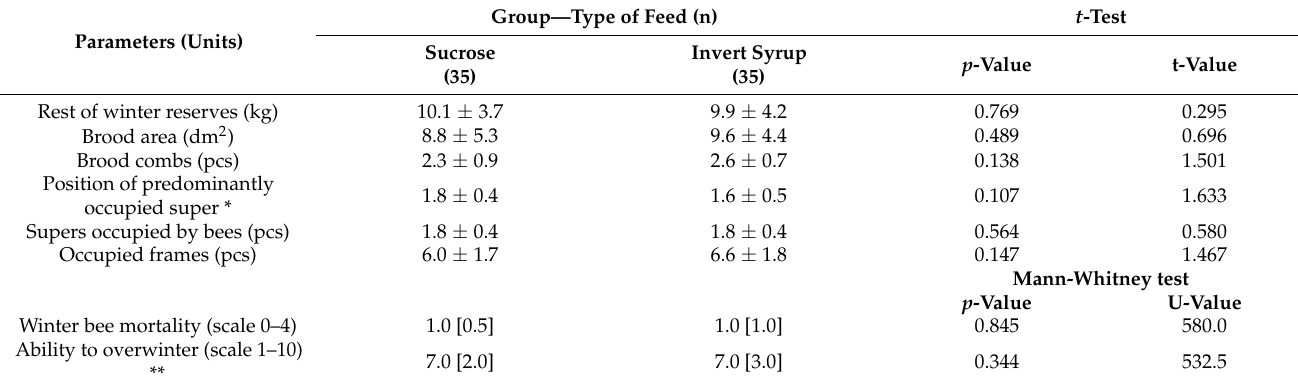
Table 3. Condition of just overwintered colonies in early spring. Differences were statistically tested (df = 68) by t -test in case of data on a ratio scale and Mann–Whitney test for data on an ordinal scale. No difference was statistically significant in dependence of the type of feed.